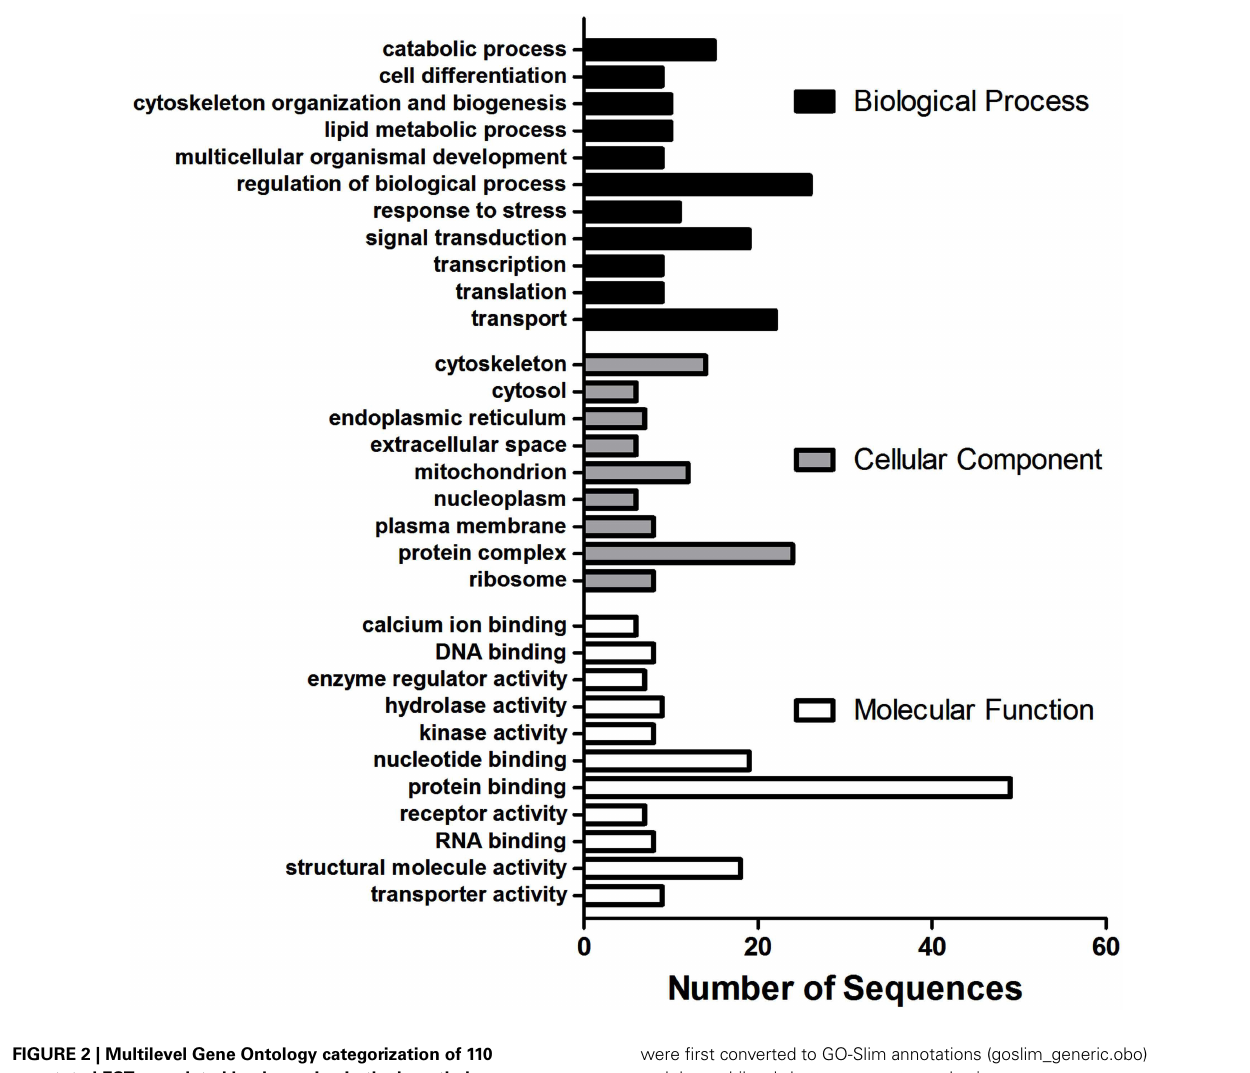
FIGURE 2 | Multilevel Gene Ontology categorization of 110 annotated ESTs regulated by dopamine in the hypothalamus into their corresponding Biological Process, Cellular Component, and Molecular Function terms. GO Annotations